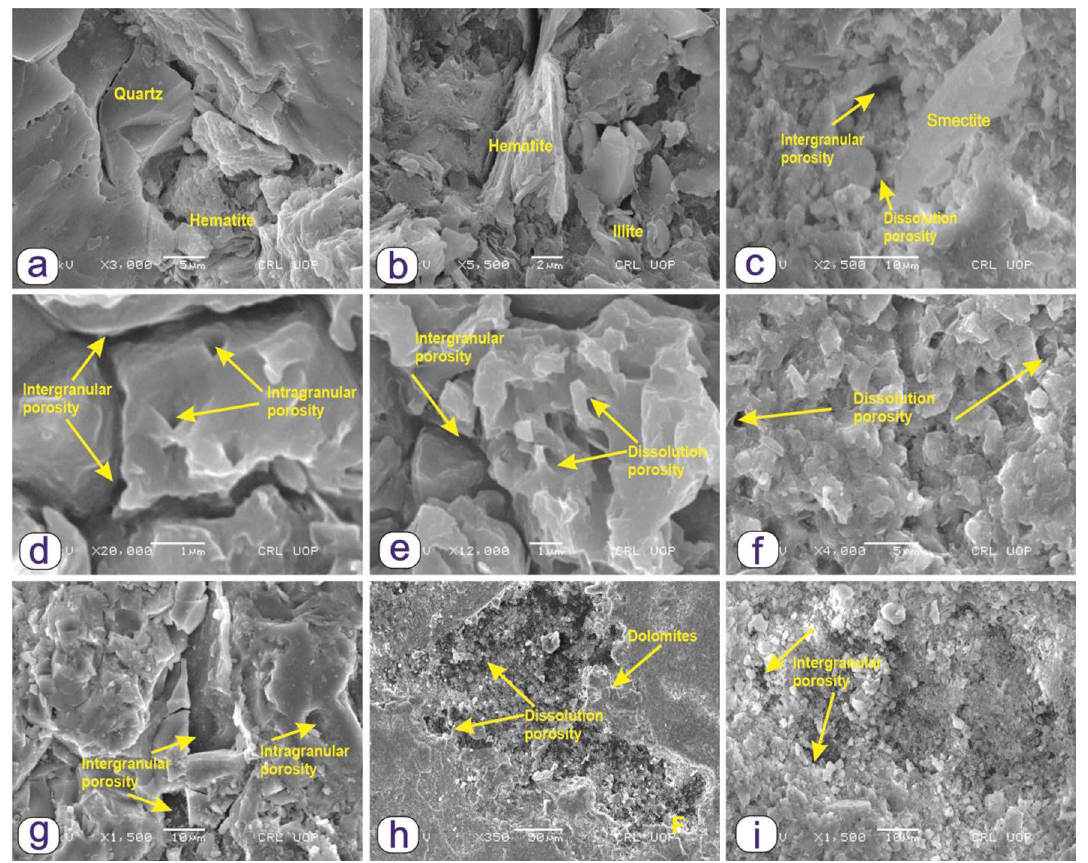
Fig. 4 Scanning electron microscopic images of the Datta a – c , Shinawari d – f , and Samana Suk g – i formations, Kala Chitta Range, Northwest